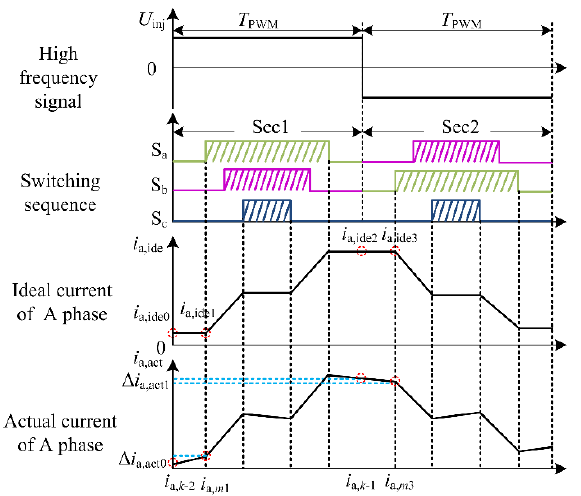
Figure 5. Changes of A-phase current with the traditional method.